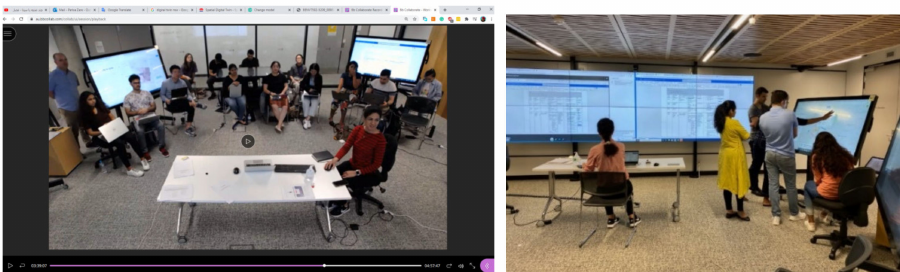
Figure 5. Hybrid geo-design workshop ( left ), participants in groups using touch tables ( right ).